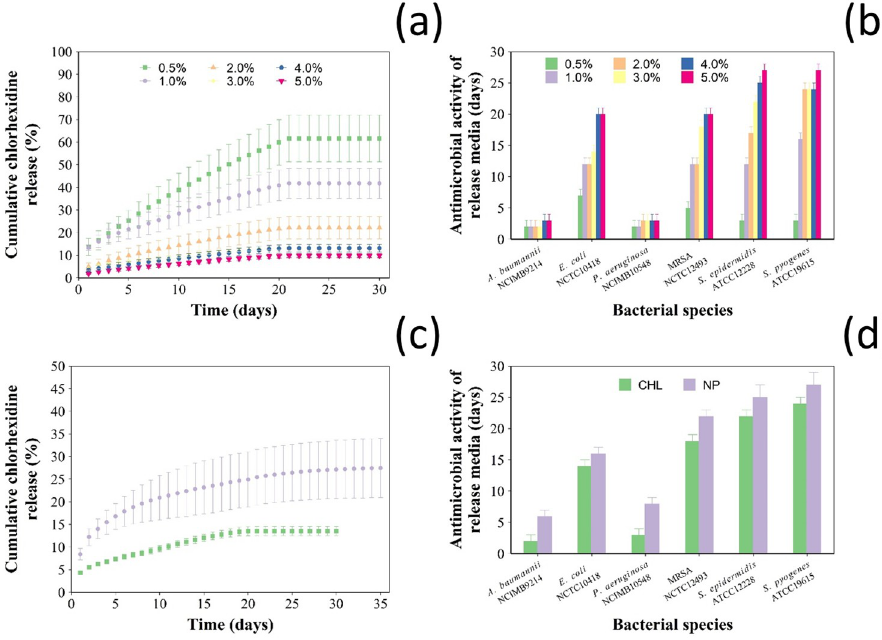
Fig 3. Chlorhexidine release from nanocarriers. (a) Cumulative chlorhexidine release in PBS (pH 7.3) and (b) duration of antimicrobial activity of Cemex 1 with different concentrations of pure chlorhexidine (0.5, 1, 2, 3, 4, 5% w/ w) (mean ± SD, n = 3). (c) Cumulative percentage of chlorhexidine release in PBS (pH 7.3) and (d) duration of antimicrobial activity of Cemex with 3% w/w chlorhexidine either as pure powder or in coated NPs (mean ± SE, n =